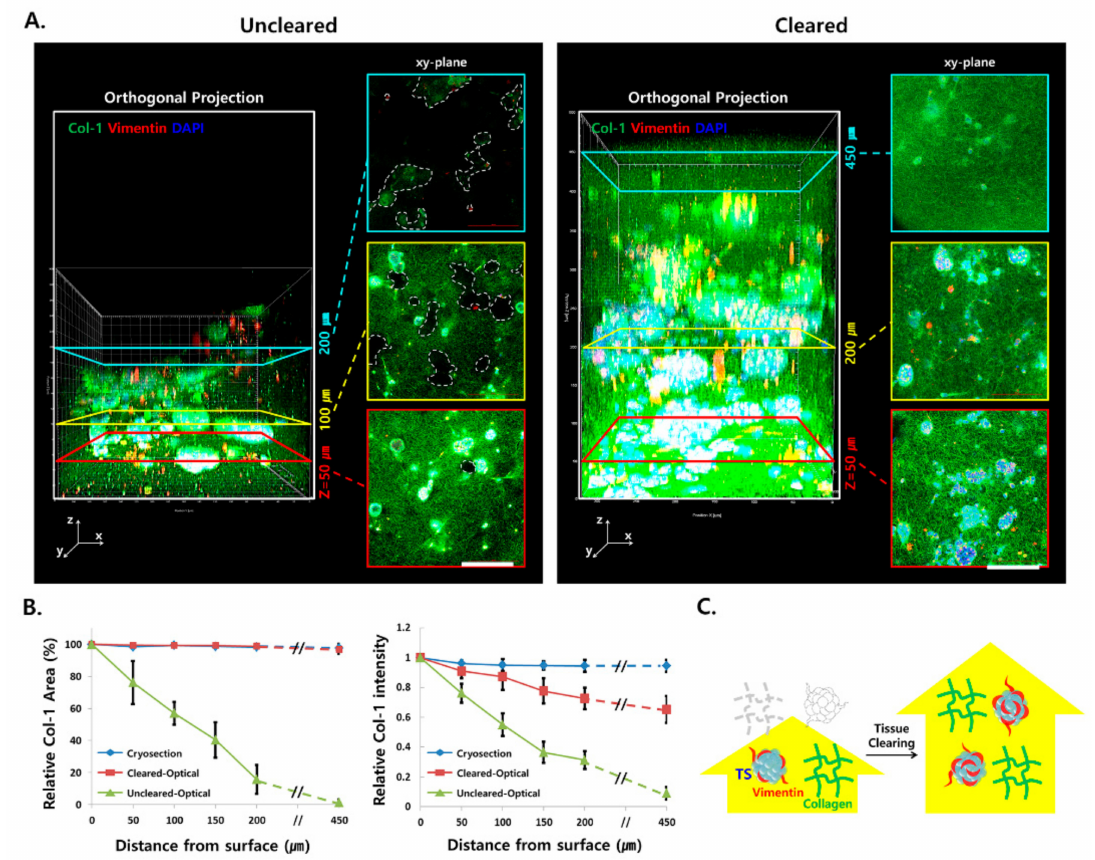
Figure 4. Increased imaging depth in Capan-1 microtumor following tissue optical clearing (TOC). ( A ) Comparison of 3D-rendered optical images of a microtumor with or without TOC. Optical sections were acquired at 5- µ m intervals along the z -axis for 3D reconstruction. ( B ) Fluorescence area and intensity of collagen over 450- µ m distance in cryosections and optical sections with or without TOC. The fluorescence area and intensity were shown relative to those at the z = 0 µ m section. ( C ) Schematic illustration of improved light transmittance by TOC in microtumors stained with type I collagen (green), vimentin (red), and DAPI (blue). Data represent the mean ± SD of three independent experiments. Scale bars: 200 µ m. Col-1; type I